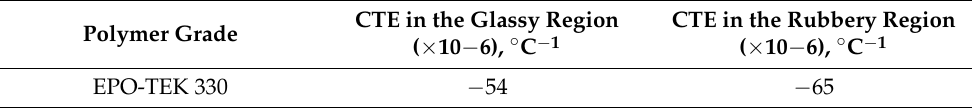
Table 2. Coefficients of thermal expansion, according to the manufacturer [22].